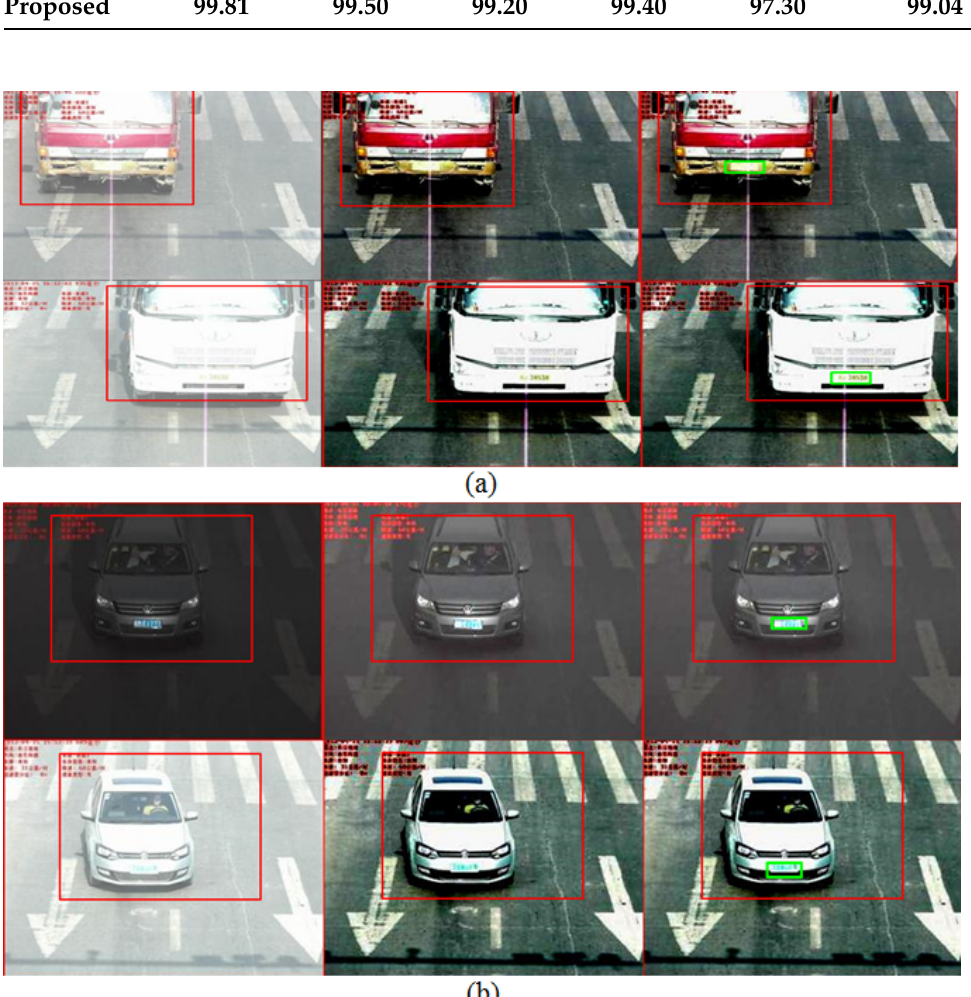
Figure 3. Detection results on ( a ) PKU-G5 extreme reflective glare and ( b ) top-row: low luminance and bottom-row: excessive